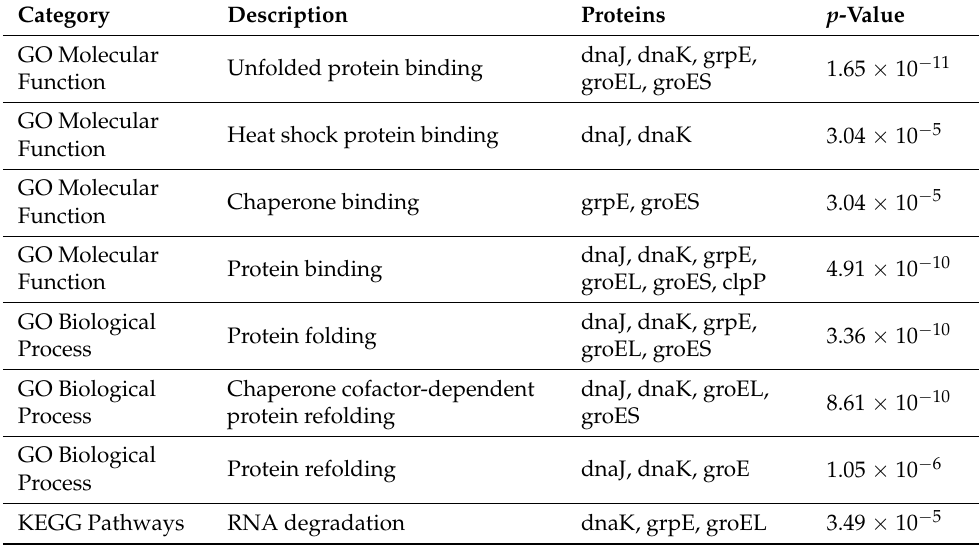
Table A2. STRING functional enrichment analysis for top 7 nodes for stress